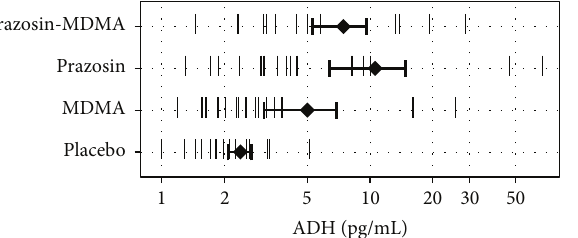
Figure 2: Antidiuretic hormone (ADH) after placebo, MDMA, prazosin, and prazosin with MDMA in Study 1. Diamonds and error bars indicate mean and SEM,